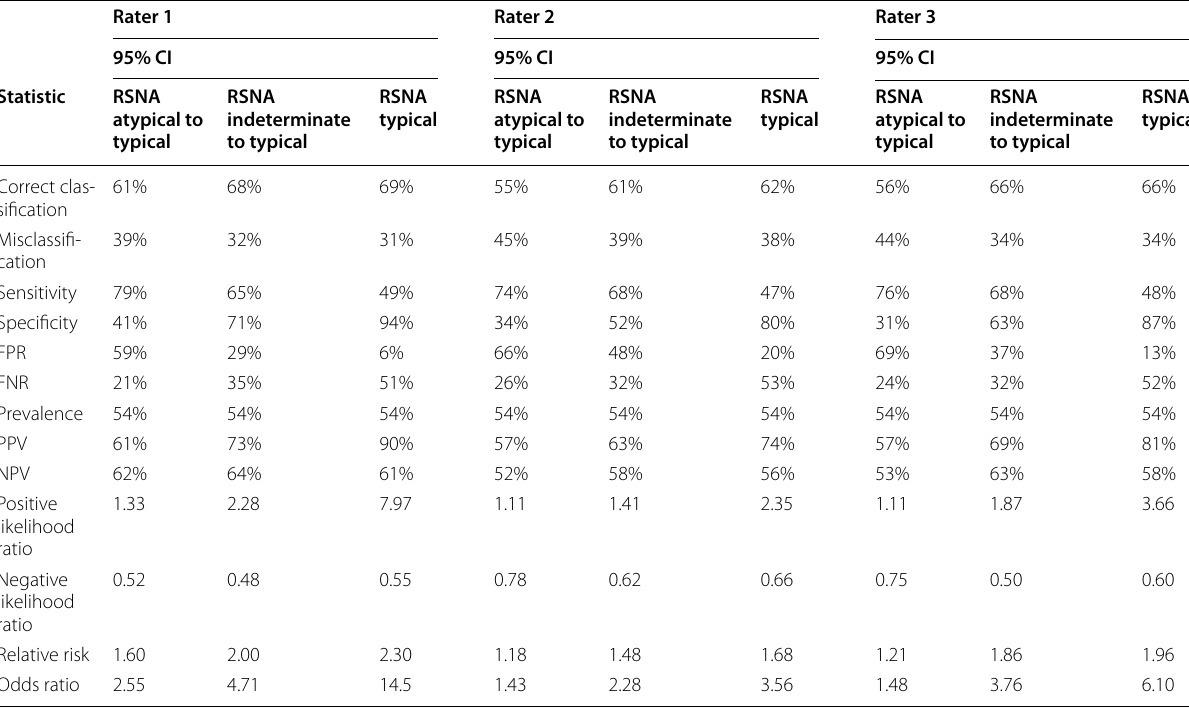
95% confidence interval. =